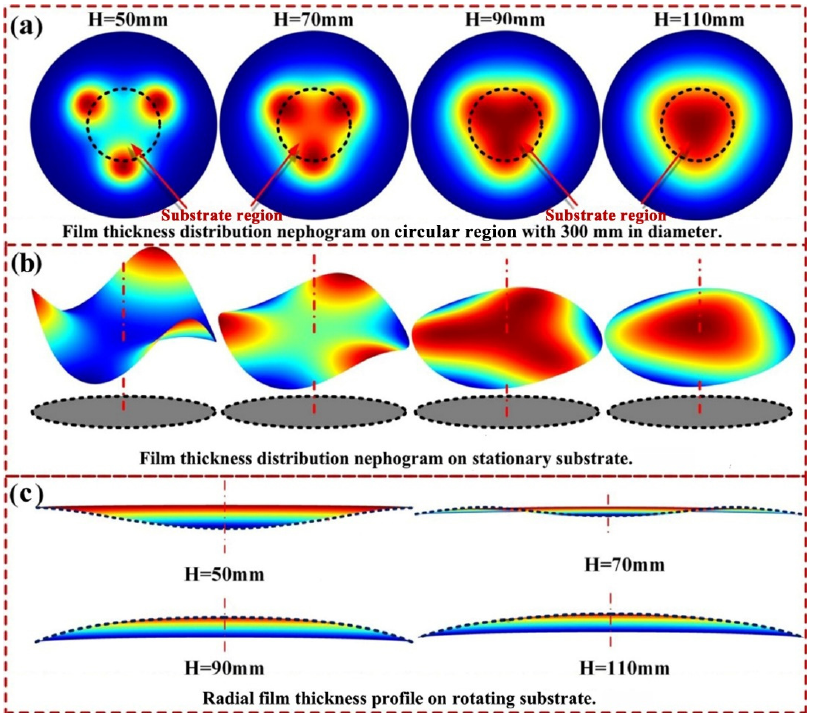
Figure 8. Evolution mechanisms of the deposition uniformity of the triple-target magnetron co- sputtering system with the target-substrate distance. ( a ) Film thickness distribution nephograms on the circular region with a diameter of 300 mm; ( b ) 3D nephograms of the film thickness distribution on the stationary substrate; ( c ) Section profiles of the film thickness distribution on the rotating sub- strate.